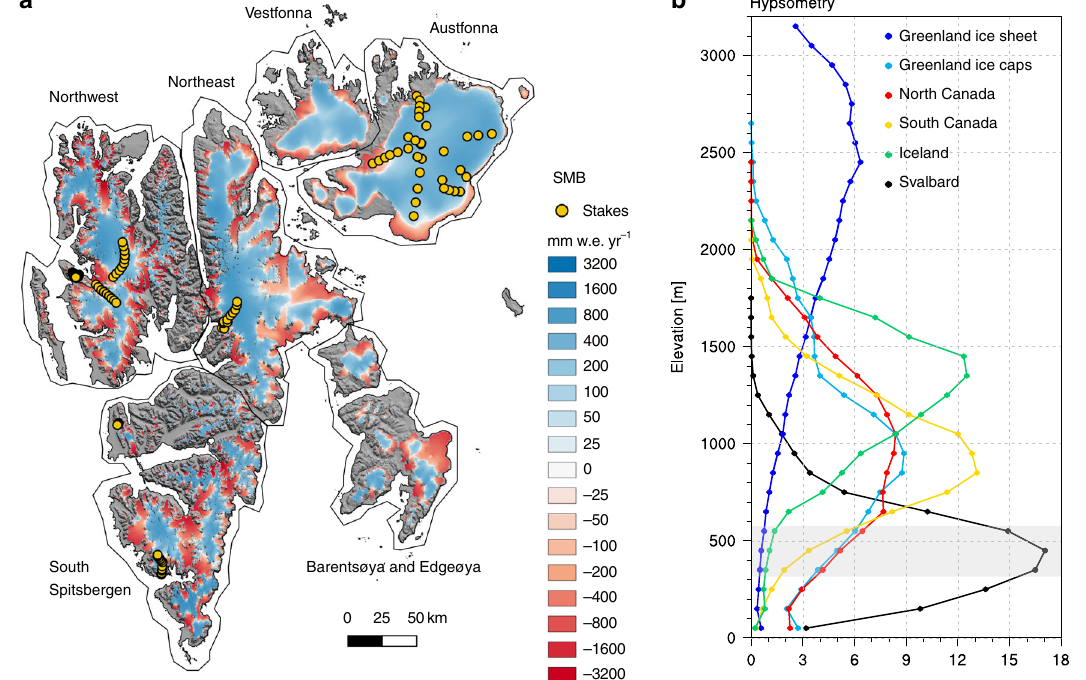
Fig. 1 Svalbard surface mass balance and hypsometry. a Modelled surface mass balance (SMB) statistically downscaled to 500 m spatial resolution, averaged for the period 1958 – 2018. Orange dots locate the 101 stakes used for model evaluation (Supplementary Fig. 2a). The sectors of Svalbard evaluated in Supplementary Fig. 2b are also outlined. b Hypsometry of six Arctic ice masses: Svalbard (S0 Terreng DEM), Iceland (Arctic DEM), North and South Canadian Arctic Archipelago (Canadian DEM) 24 , Greenland ice sheet (GIMP DEM) 41 , Greenland peripheral glaciers and ice caps (GIMP DEM) 23 . The x -axis shows the glacier area in each 100 m elevation band as a fraction of the total ice area of that region